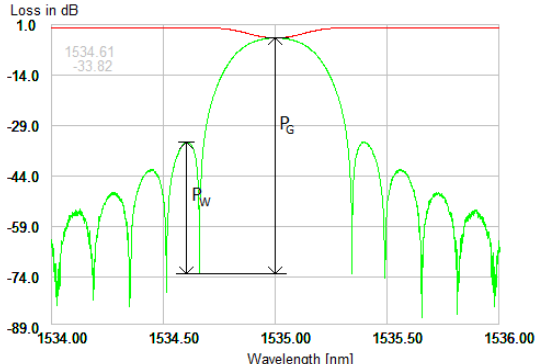
Fig. 23. Technique of defining peak capacity is high.